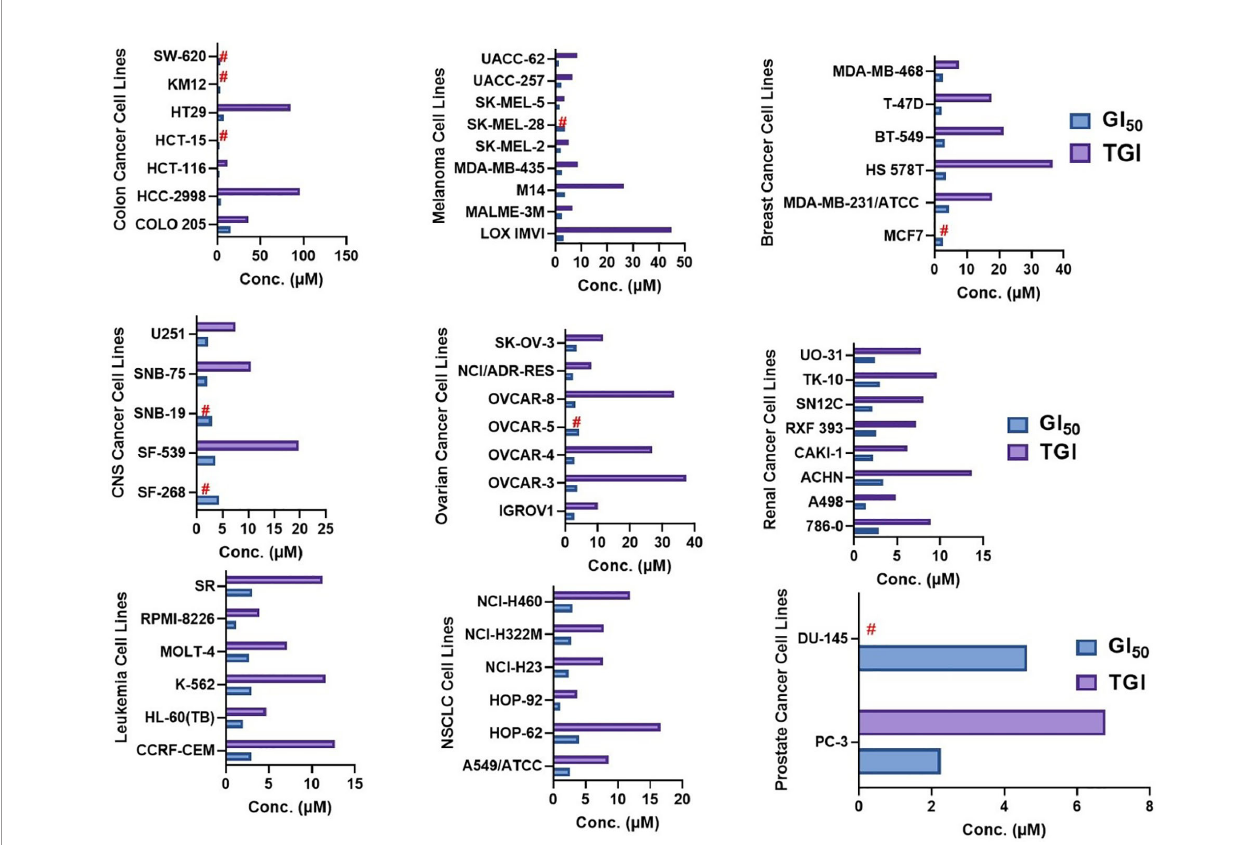
FIGURE 11 | GI 50 (50% inhibition of the cancer cell growth) and TGI (100% growth inhibition of the cancer cells) concentrations of NSC765598 against NCI60 panels of human cancer cell